Question: Which kind of chart has been used to present this data?
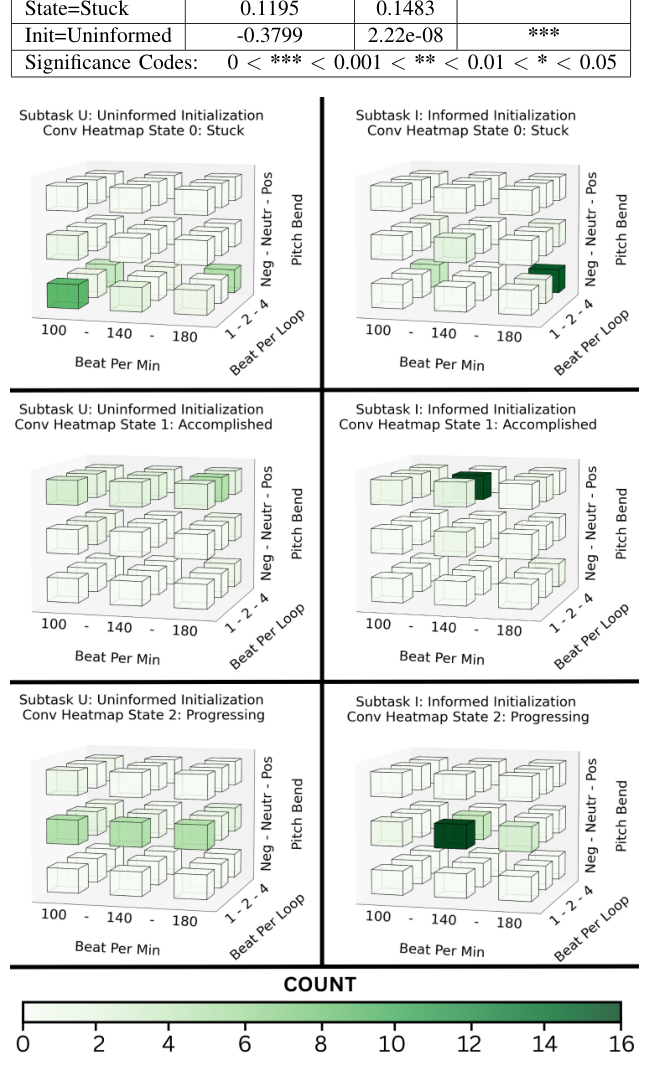
Answer: heatmap